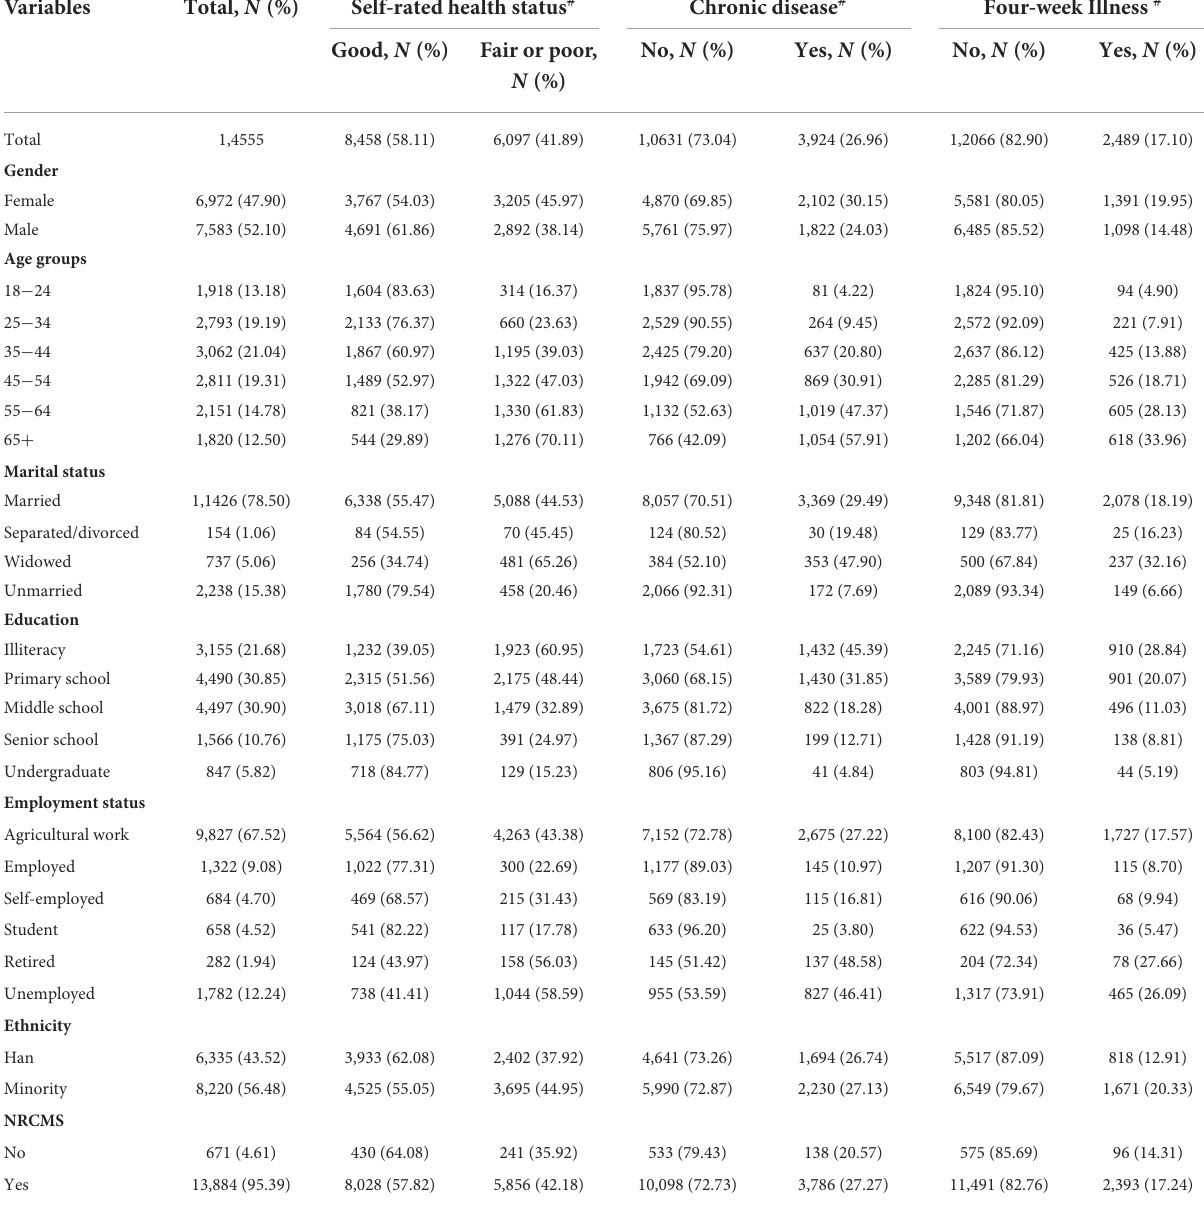
TABLE 1 Descriptive statistic for health status, demographic, socioeconomic and other characteristics of the Chinese western rural adults in 2014 ( N = 14,555). Variables Total, N (%) Self-rated health status # Chronic disease # Four-week Illness